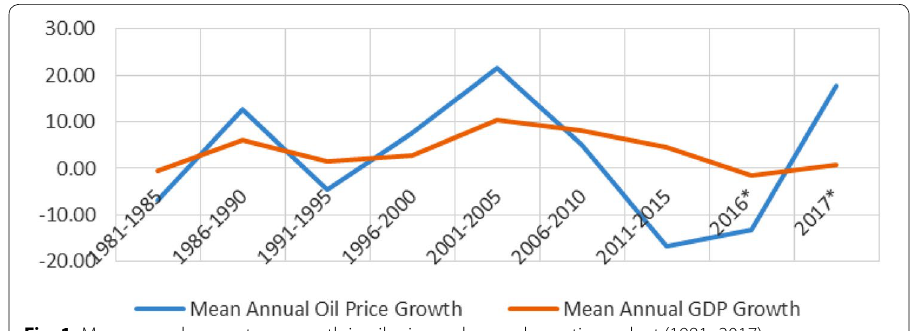
Fig. 1 Mean annual percentage growth in oil price and gross domestic product